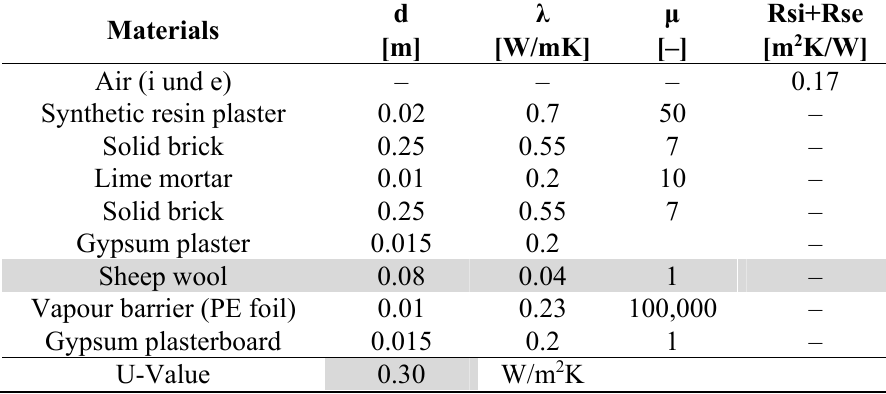
Table 3. Internal insulation with sheep wool. External wall renovation with 8 cm sheep wool, internal insulation.